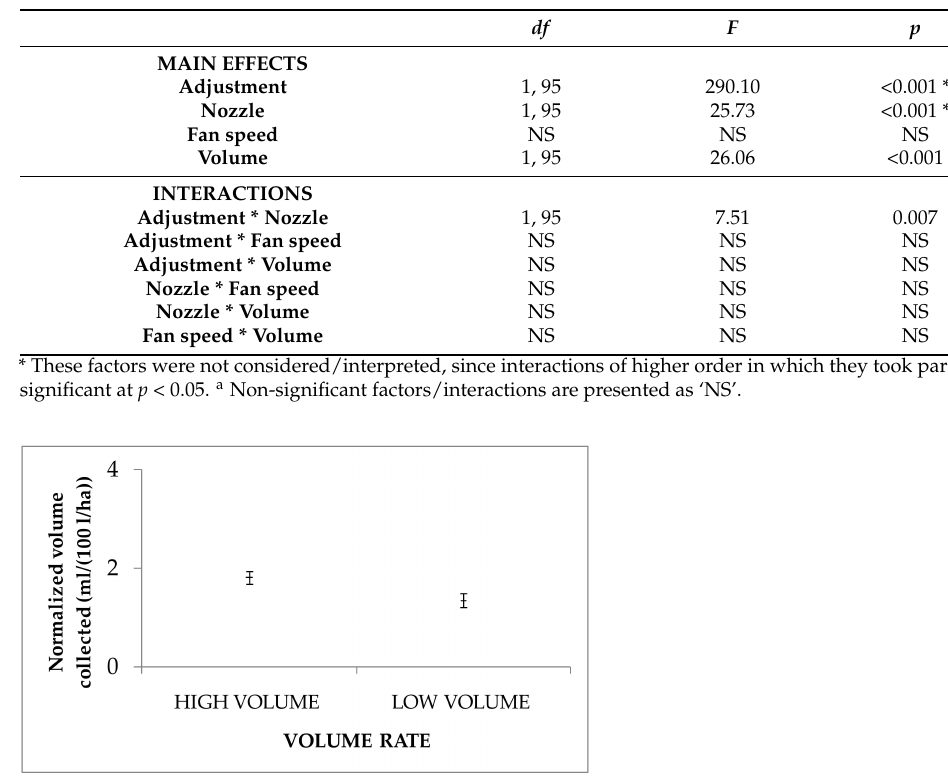
Table 10. Two-way ANOVA results for the normalized volume collected above the Canopy height with the C2 sprayer (least significant difference (LSD) test, p < 0.05) a .